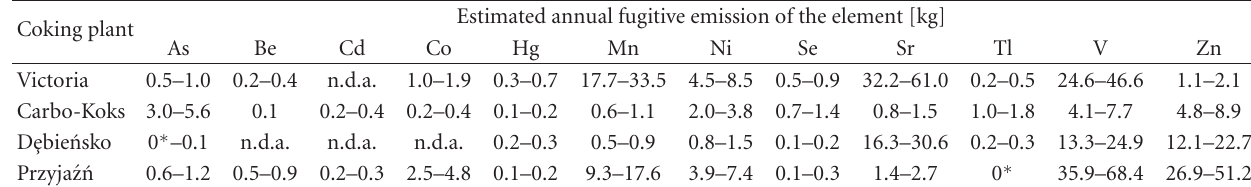
Table 7: Ranges of estimated annual fugitive emission of trace elements from the tested coke oven. Coking plant